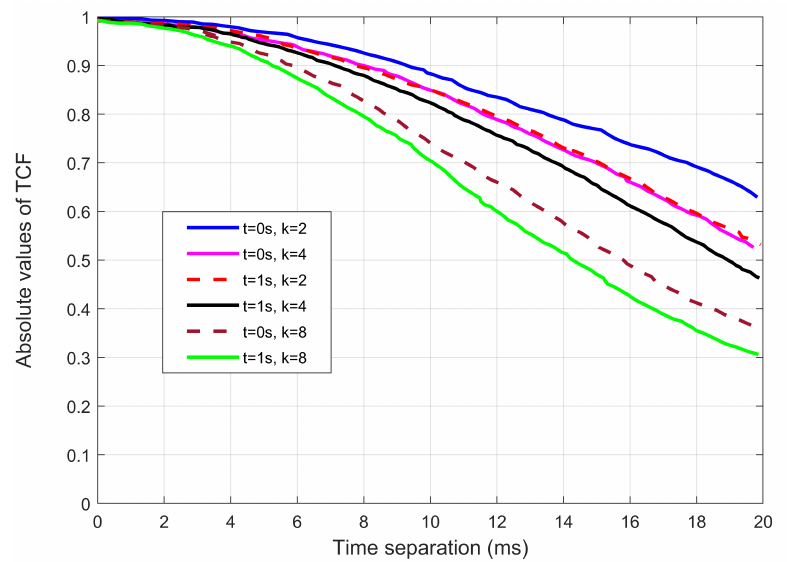
Figure 4. The relationship between the k distributions of intra-cluster paths and time correlations for azimuth